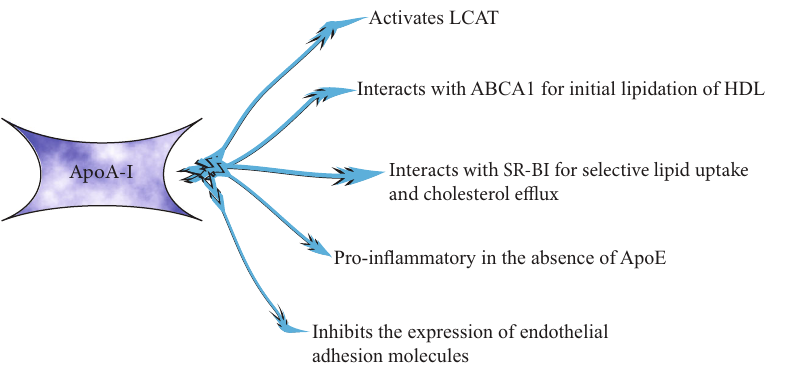
Figure 2: The biological functions of ApoA-I. In the liver, ApoA-I initiates the biogenesis of HDL and the lipid uptake and promotes cholesterol e ffl ux. In the vascular endothelium, it maintains endothelial cell homeostasis. ApoE: apolipoprotein E; ABCA1: ATP-binding cassette transporters; LCAT: lecithin-cholesterol acyltransferase; SR-BI: scavenger receptor class B type I.